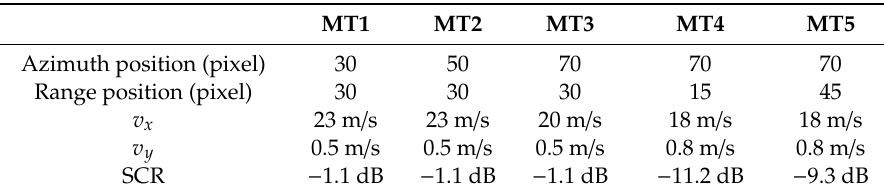
Figure 3. The simulated MTs and SAR data. ( a ) the geometry relationship of the MTs, ( b ) the range-compressed SAR data, and ( c ) the range-compressed MT radar data. Table 2. Simulation parameters of the MTs.